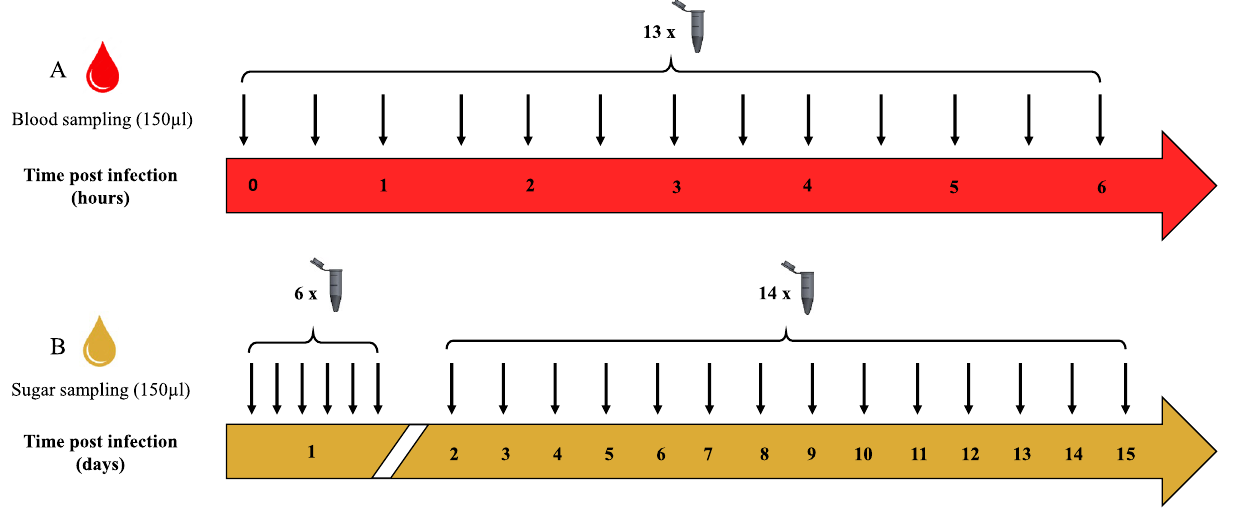
Figure 4. Sampling method for the assessment of TOSV persistence ( A ) in rabbit blood at 37 °C and ( B ) in sugar solution at 26